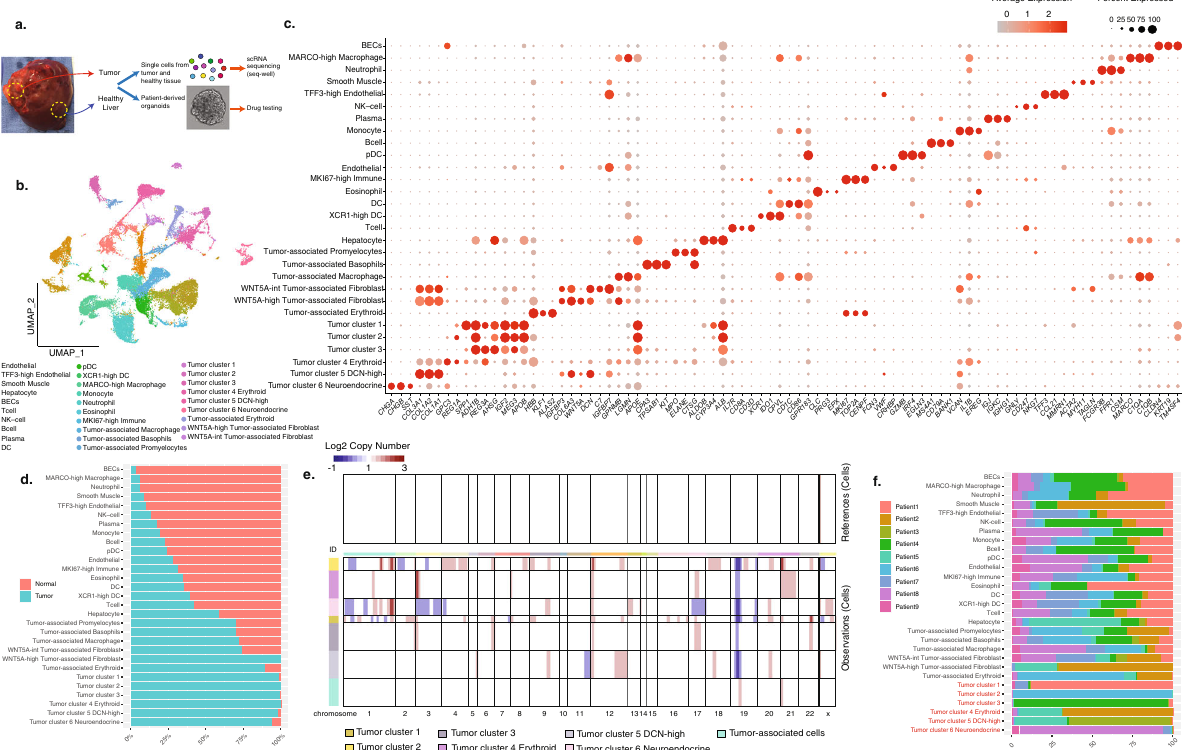
Fig. 1 | Single-cell pro fi ling of HB patients reveals distinctive tumor cell populationsandtumor-associatedpopulations.a Flowchartoftissueprocessing of HB tumor and adjacent paired normal tissue samples for single-cell RNA sequencing and patient-derived spheroid culture. b Uniform manifold approx- imationandprojection(UMAP)of29,968cellsfromnineHBpatients,annotatedby cell types. c Dot plot of all identi fi ed populations, each characterized by three known cell type markers. Average expression was indicated by the color gradient, andthepercentageofmarkerexpressedwasrepresentedbythedotsize. d Stacked